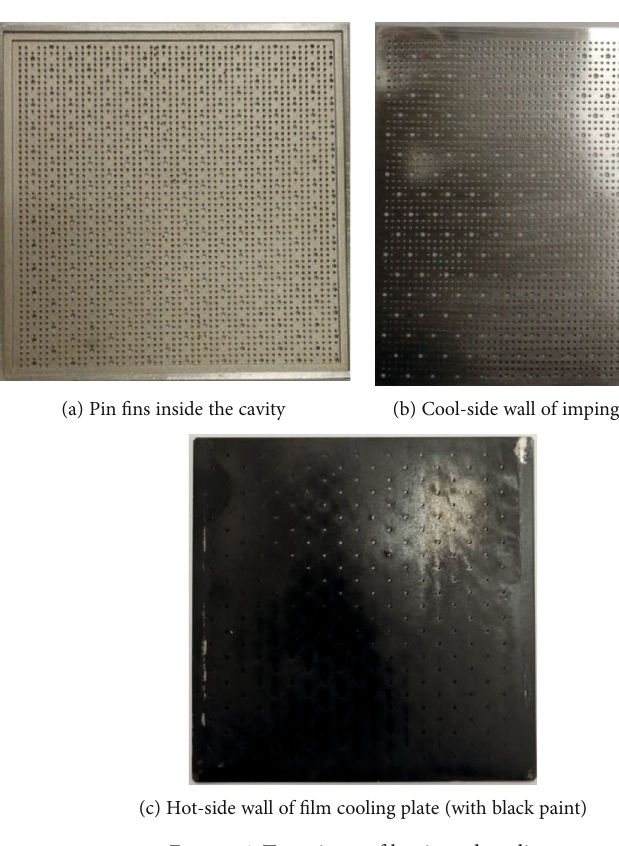
Figure 6: Test pieces of laminated cooling. Table 2: Detailed geometric parameters for test